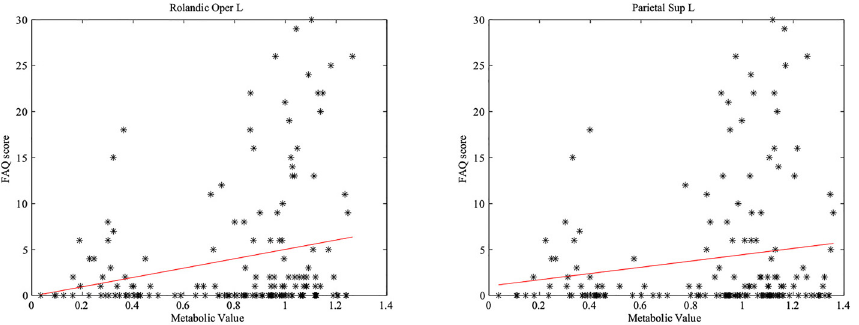
Fig 2. The FAQ scores and the average metabolism in left rolandic operculum and left superior parietal gyrus in APOE ε 4 carriers.